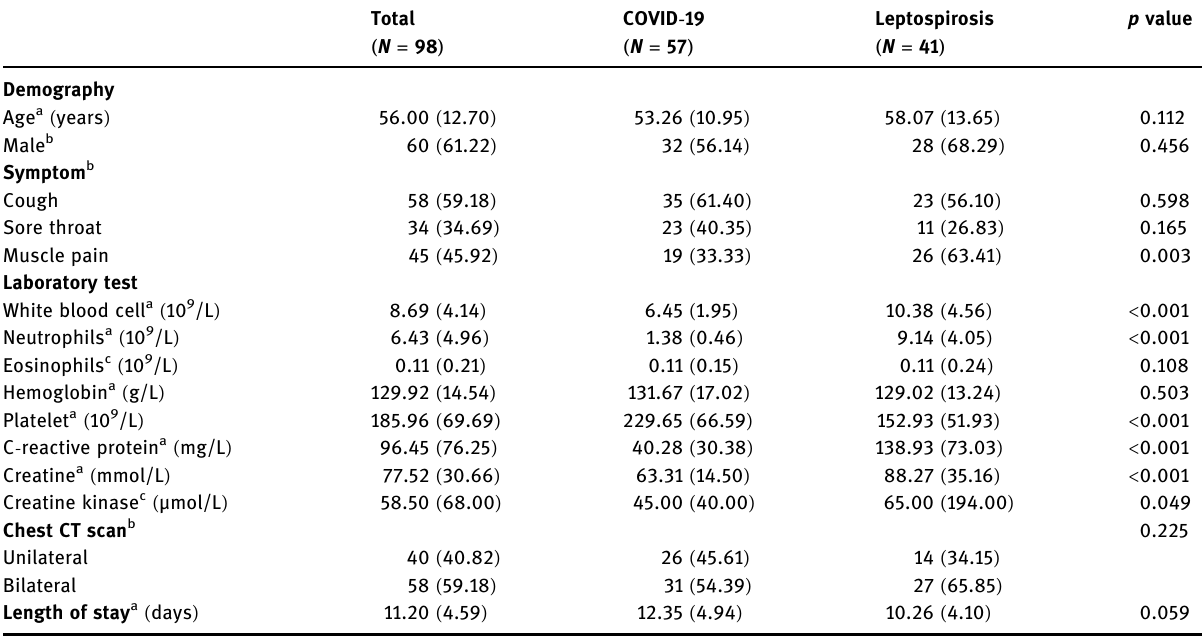
Table 2: Disparity in clinical characteristics between COVID - 19 and leptospirosis Total COVID - 19